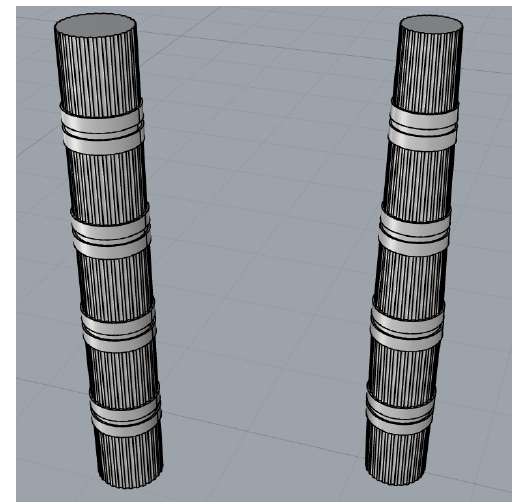
Figure 7. Algorithmic models of the shaft, on the left without entasis deformation and on the right with the